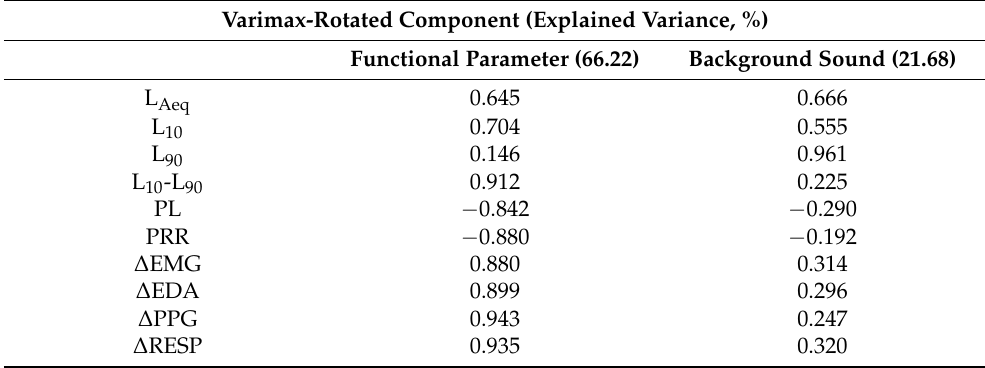
Table 4. Summary of principal component analysis (PCA) on physiological restorative parameters. Varimax-Rotated Component (Explained Variance,